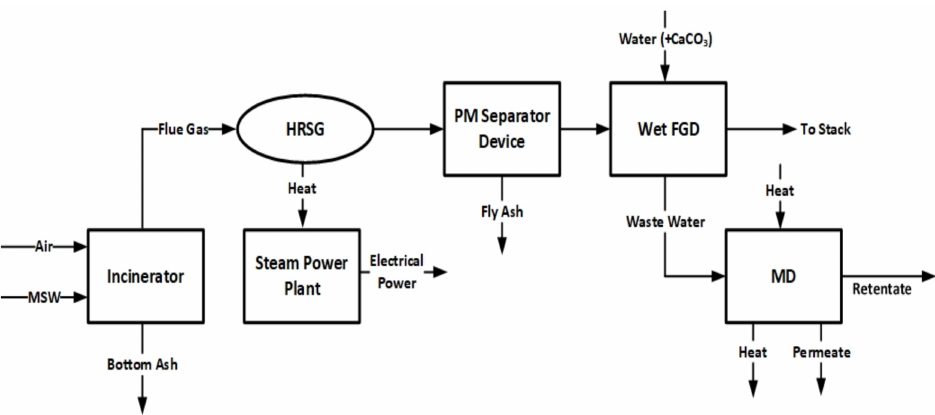
Figure 2. Block flowchart of incineration plant used for the